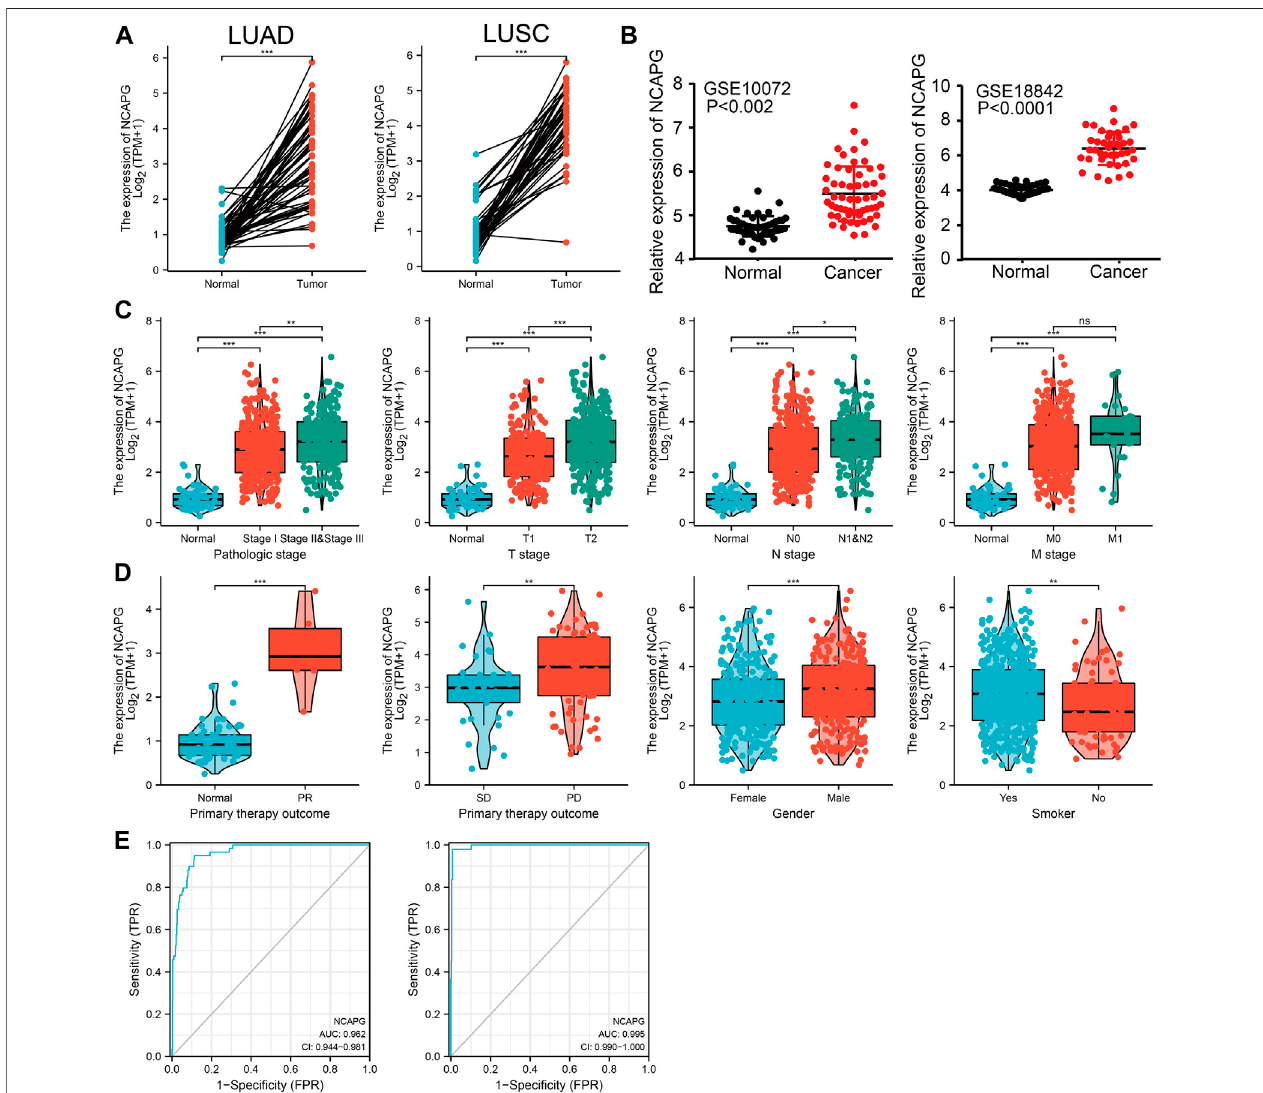
FIGURE 2 | NCAPG was a high expression in NSCLC. (A – D) The expression of NCAPG in NSCLC was examined by TCGA and GEO databases. (C,D) NCAPG expression is associated with clinicopathological characteristics in NSCLC. (E) Receiver operating characteristic analysis (ROC) of NCAPG in NSCLC. (* p < 0.05, ** p < 0.01, *** p < 0.001).